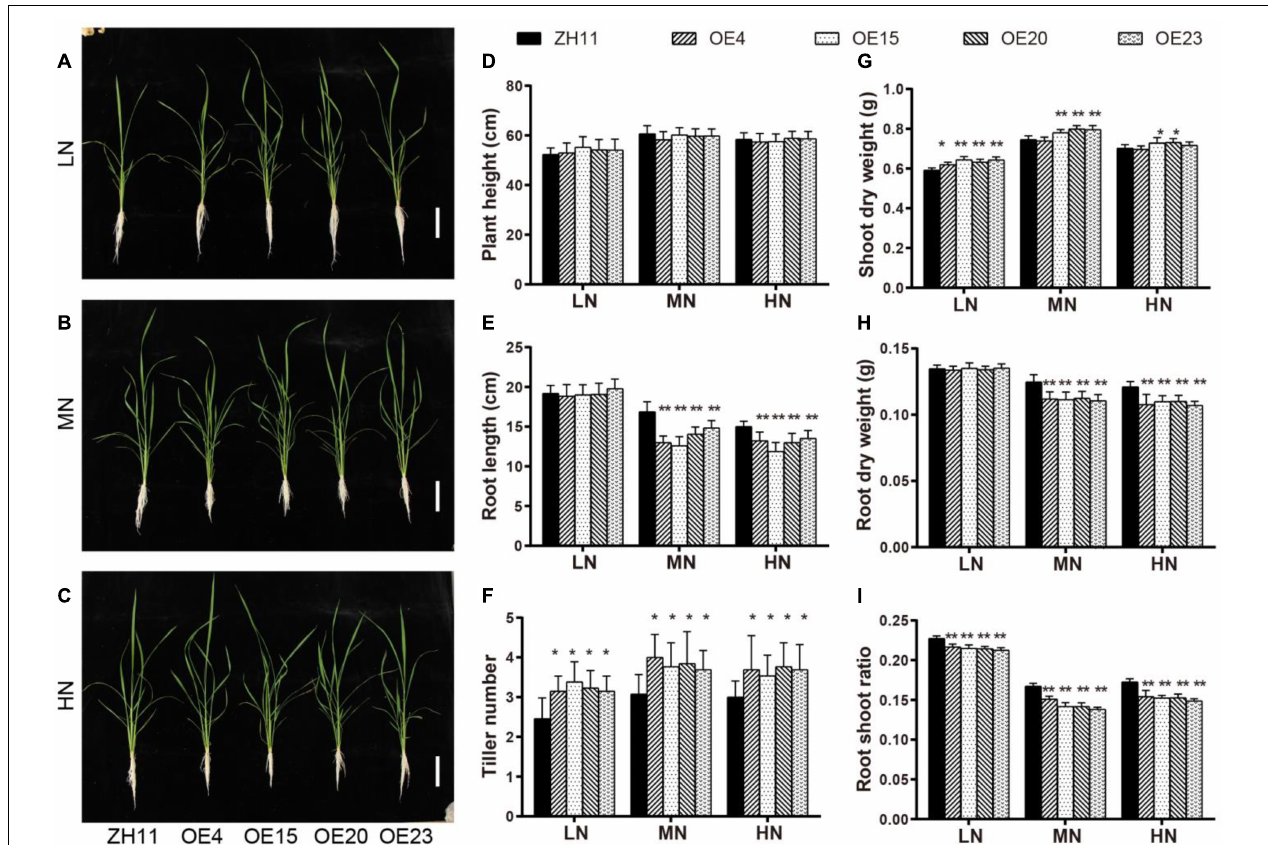
FIGURE 3 | Performances of OsMYB305 -overexpressing lines under different level of N supply. (A–C) Phenotype of OsMYB305 -OE lines (OE4, OE15, OE20, OE23) and wild-type (ZH11) seedlings growing in hydroponic culture for 2 weeks. LN: 0.288 mM NH 4 NO 3 ; MN:0.72 mM NH 4 NO 3 ; HN:1.44 mM NH 4 NO 3 . (D–I) Statistic analysis of the growth parameters. Scale bars represents 10 cm. Values were means ± SD of 6 biological replications. Statistical significance was determined by Student’s t -test (* P < 0.05, ** P < 0.01).